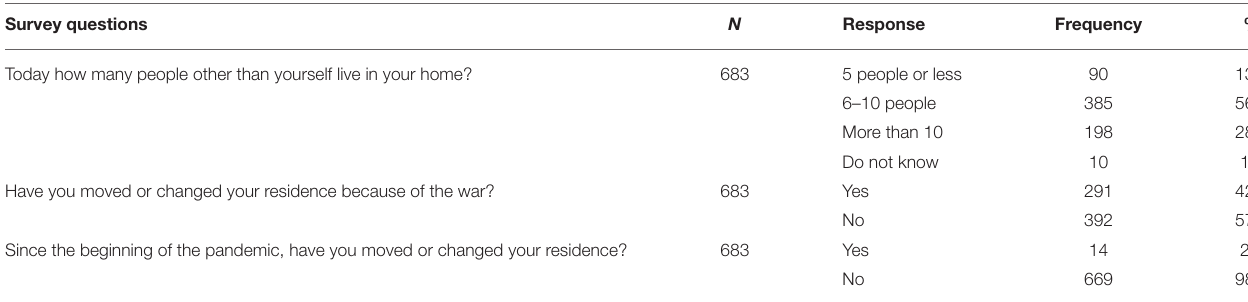
TABLE 7 | Housing and living situations ( N =